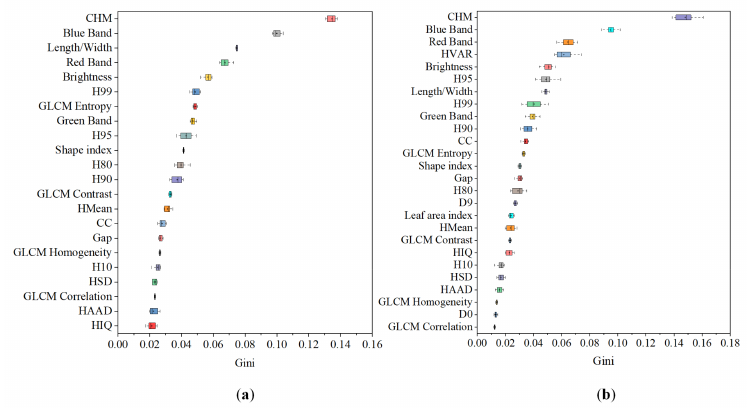
Figure 14. The difference among classes in UAV lidar metrics. The importance of the features used in Model 3 ( a ) and Model 4 ( b ), obtained by running the random forest algorithm 20